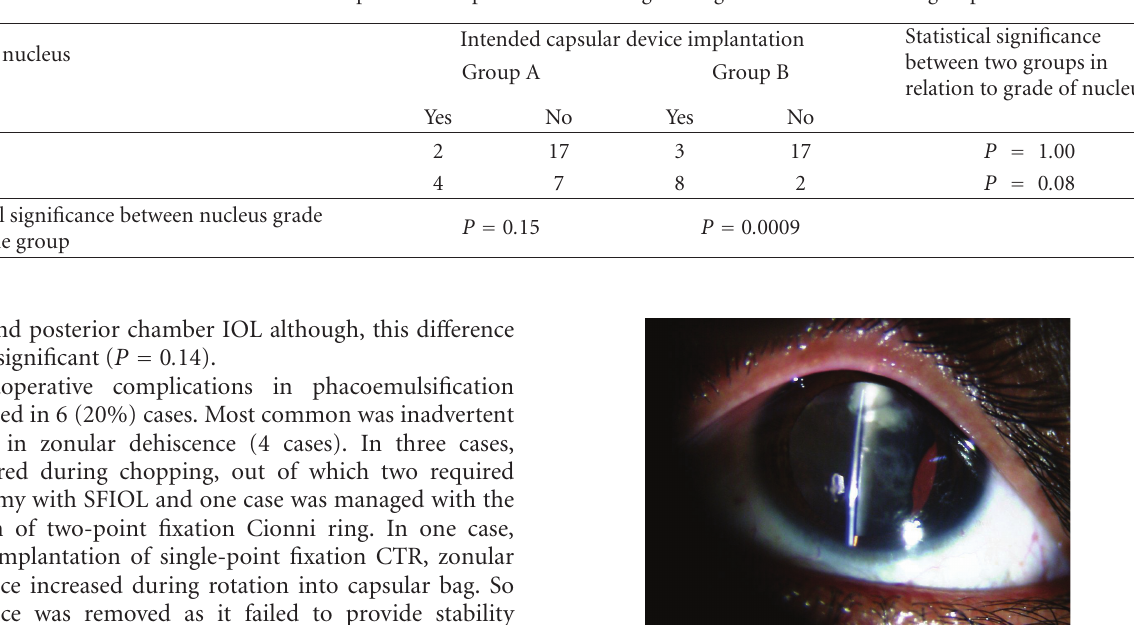
Table 3: Distribution of intraoperative complications according to the grade of nucleus in two groups.